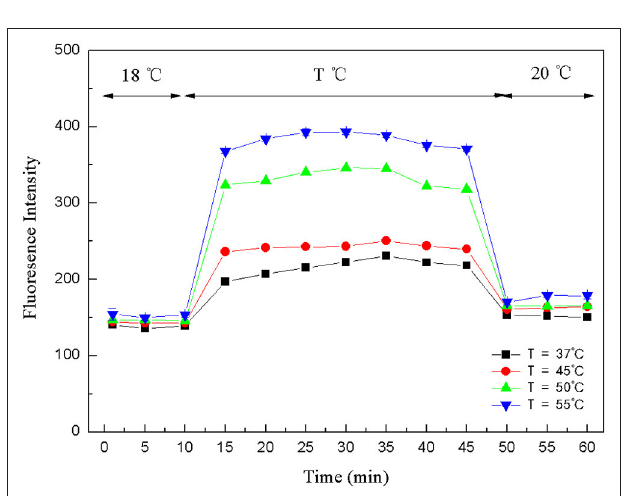
FIGURE 4 | Feasibility experiments of the structure-switching aptamers assay for kanamycin. (a) FDNA, (b) FDNA + QDNA1, (c) FDNA + QDNA1 +